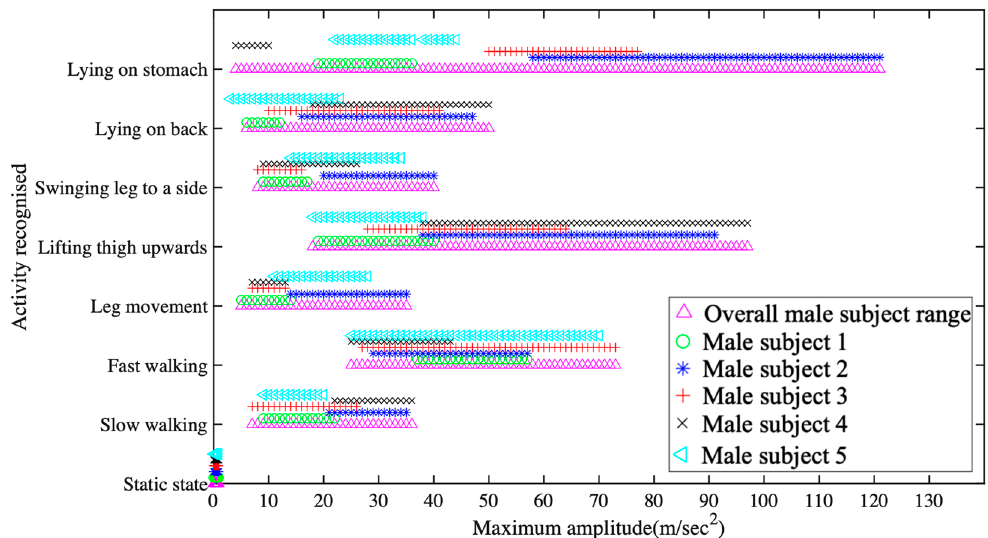
Figure 3. Personalized activity recognition comparison of five male subjects vs. overall subject range with respect to maximum amplitude.